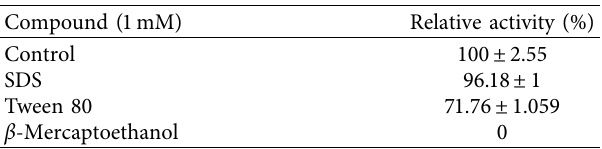
Table 4: Effect of detergents and enzyme inhibitors on K . flava Y4 lipase activity.